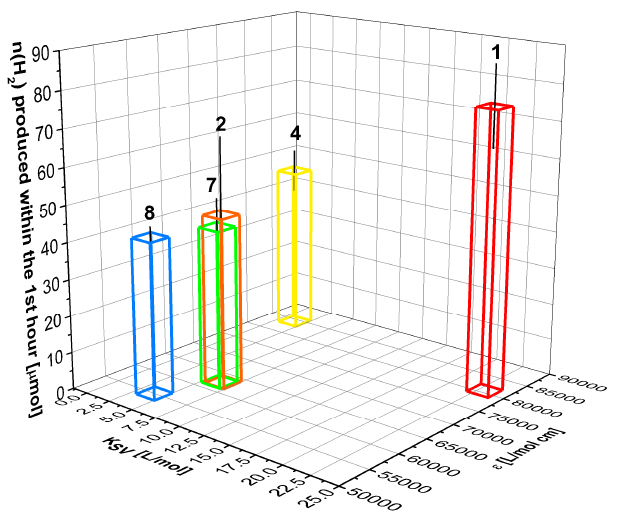
Figure 7. Effect of fluorescence quenching behaviour and absorption coefficient on the initial activity ( t = 1 h) of BODIPY dyes 1 , 2 , 4 , 7 , and 8 with sensitisation via the excited singlet state.